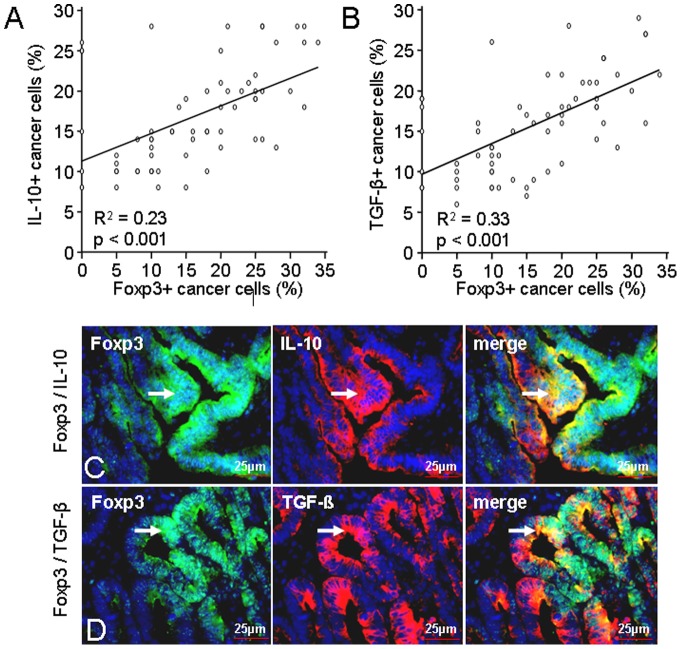
Correlation of Foxp3+ cancer cell expression with immunosuppressive cytokines IL-10+ and TGF-β+ and immunofluorescence double staining.(A/B) Significant correlation of Foxp3+ cancer cell expression with the expression of IL-10 (A) and TGF-β (B). Regression analysis; R2, coefficient of determination. (C/D) Representative example of an immunofluorescence double staining of IL-10+ (C) and TGF-β+ (D) in Foxp3+ cancer cells (arrows). FITC green Fluoresceinisothiocyanate, Cy3 red and DAPI 4′,6-Diamidino-2- phenylindoldihydrochlorid blue – nuclear counterstaining.